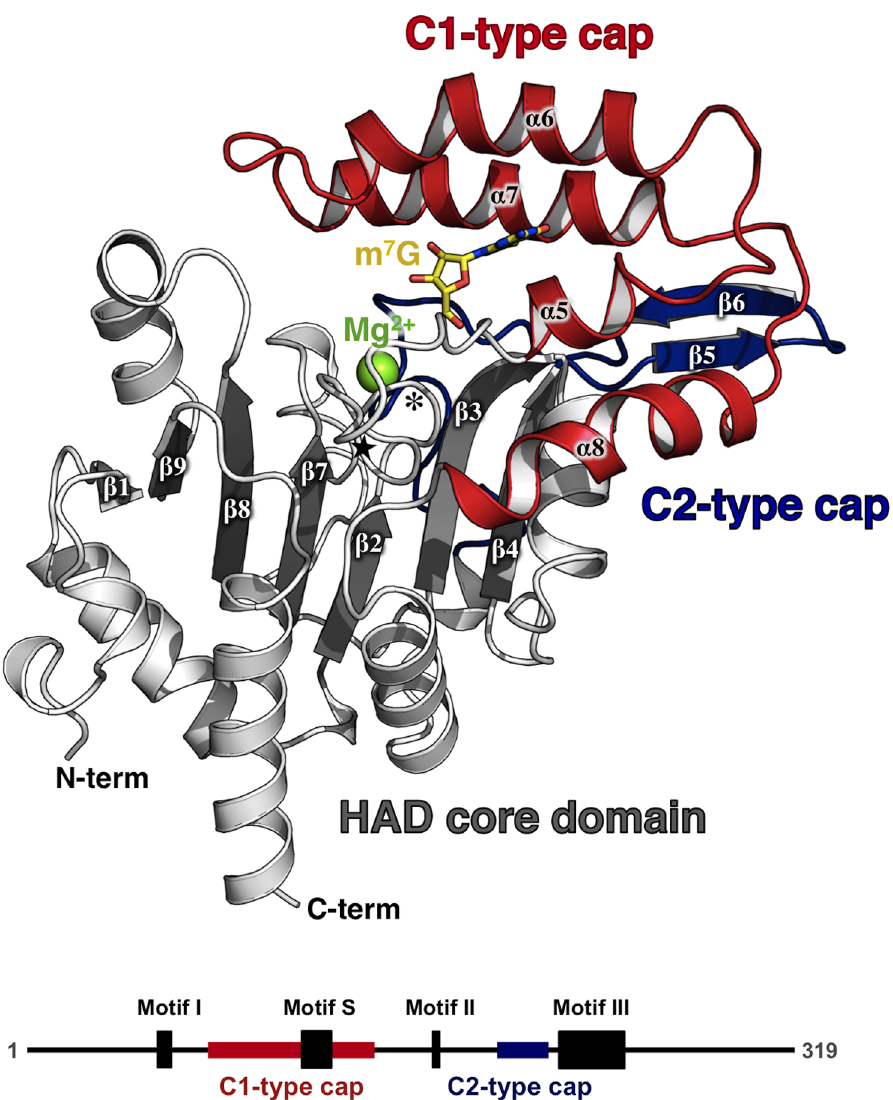
Figure 1. Overall structure of Drosophilamelanogaster cN-IIIB. Dm cN-IIIB consists of the conserved central HAD core domain (grey b -strands and white a -helices) and a cap domain. The cap domain packs against the top of the HAD core and is composed of two regions, a C1-type cap (red) and a C2-type cap (blue). The ‘‘squiggle’’ and the ‘‘flap’’, both structural key features of 5 9 -nucleotidases, are marked with an asterisk and a black star, respectively. Secondary structure elements as well as termini and the bound magnesium ion (green sphere) are labeled. The co-crystallized reaction product 7-methylguanosine (m 7 G) is bound between the cap domain and the HAD core and is represented as stick model (carbon in yellow, nitrogen in blue, oxygen in red). The lower panel shows a schematic representation of Dm cN-IIIB with the canonical 5 9 -nucleotidase motifs I-III and S as well as the positions of the cap insertions highlighted as boxes and labeled.